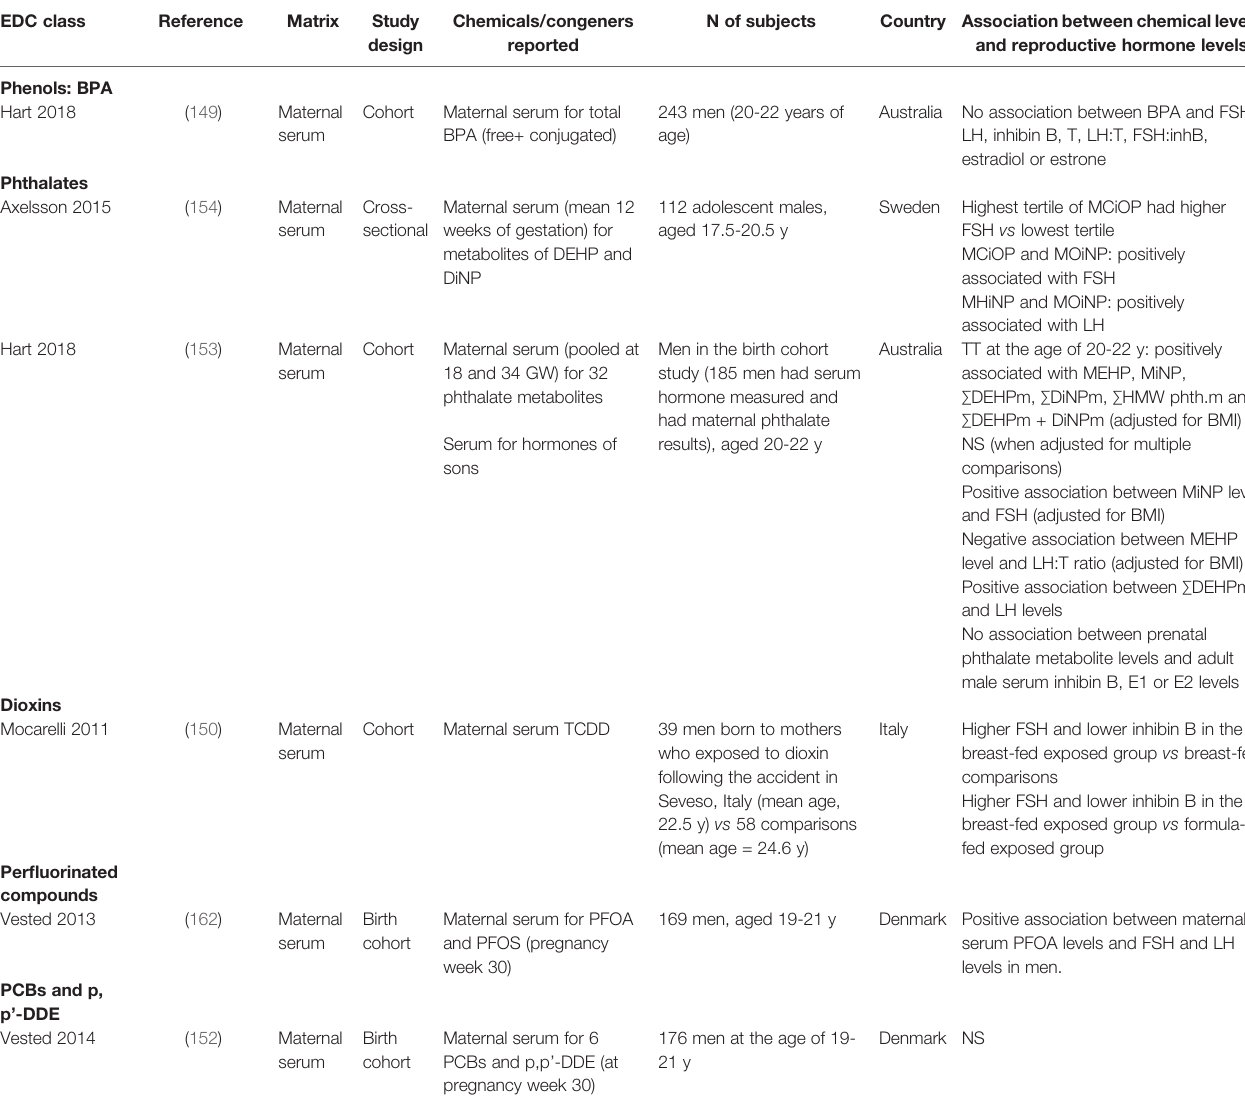
TABLE 6 | Summary of studies that evaluated early life EDC exposure and adult reproductive hormone